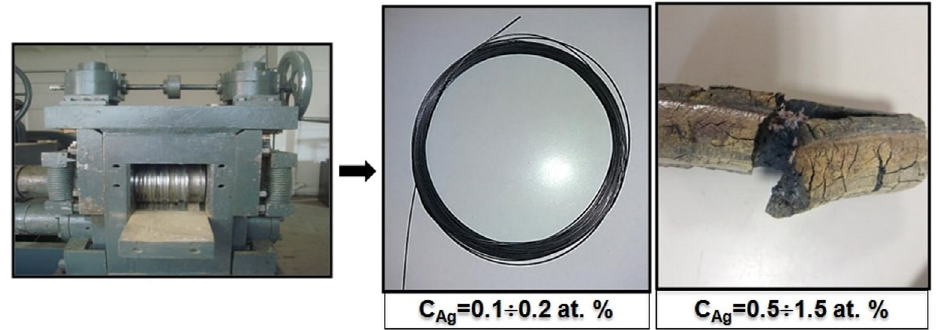
Figure 1. Rolling and drawing of TiNi–Ag with different silver content.